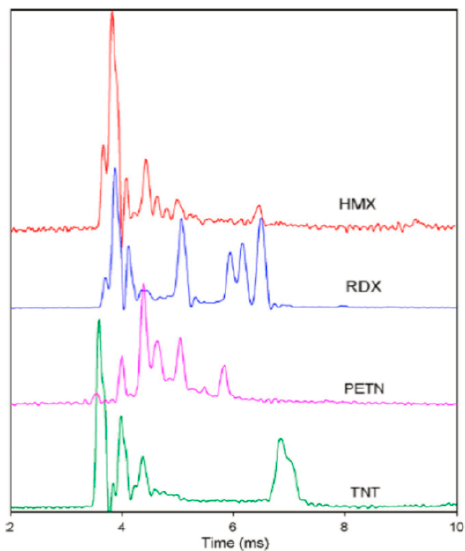
Figure 15. Positive ion mobility spectra of TNT, RDX, HMX, and PETN. Adapted from [131], with permission from © 2010 Elsevier.